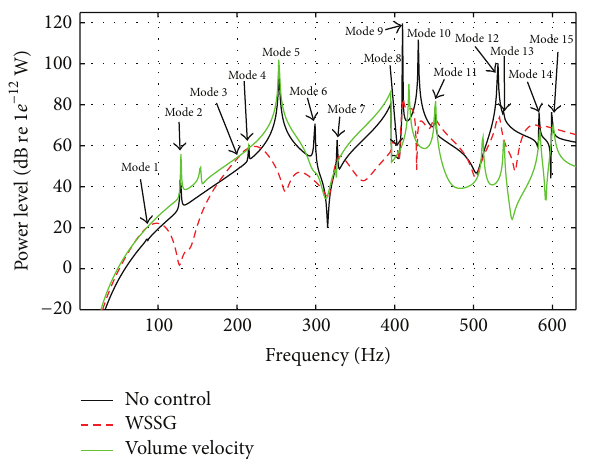
Figure 11: Sound radiated by the fourth radiation mode on the clamped rectangular plate.